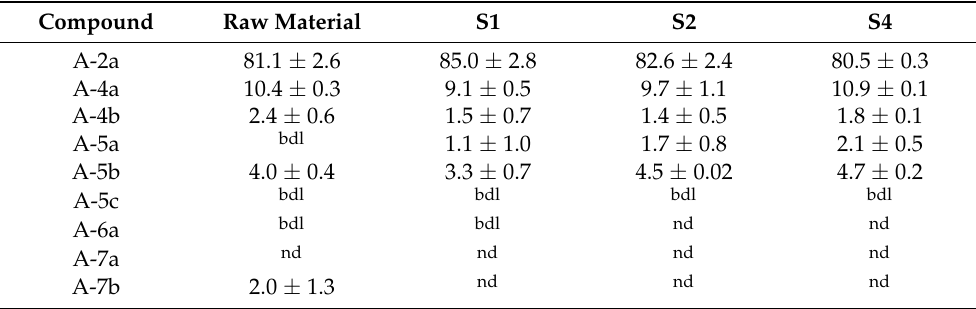
Table A6. Composition (mol%) of arabinan oligosaccharides after incubation of soluble dietary fiber (SDF) of enzymatically treated apple pomace (raw and extruded) with endo-arabinanase (mean value ± range/2, n = 2). S1: only transport elements, S2: two reverse elements, S4: two reverse elements and a kneading block, bdl: below decetion limit, nd: not